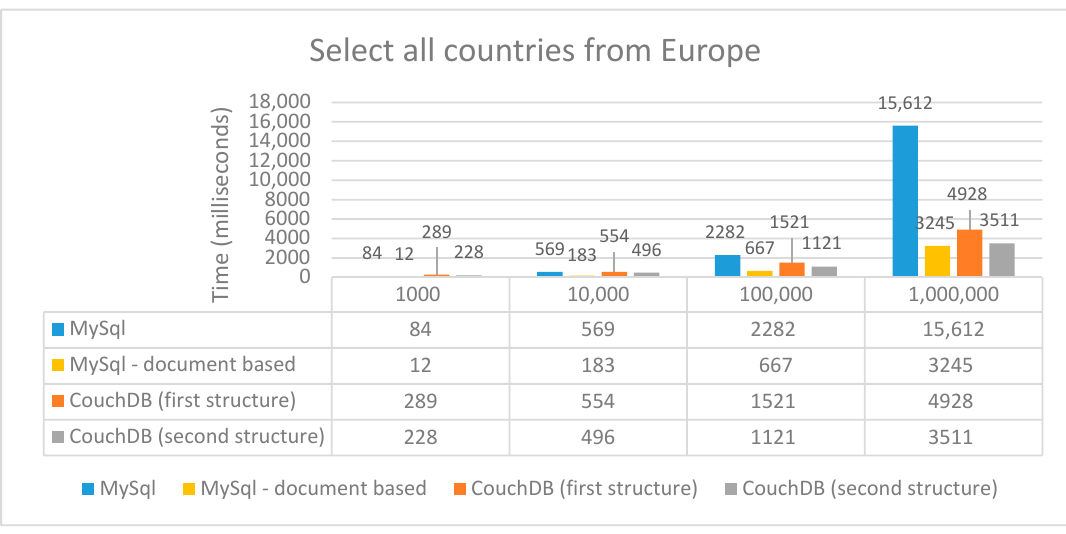
Figure 8. Performance time (ms) for select with single inner join.